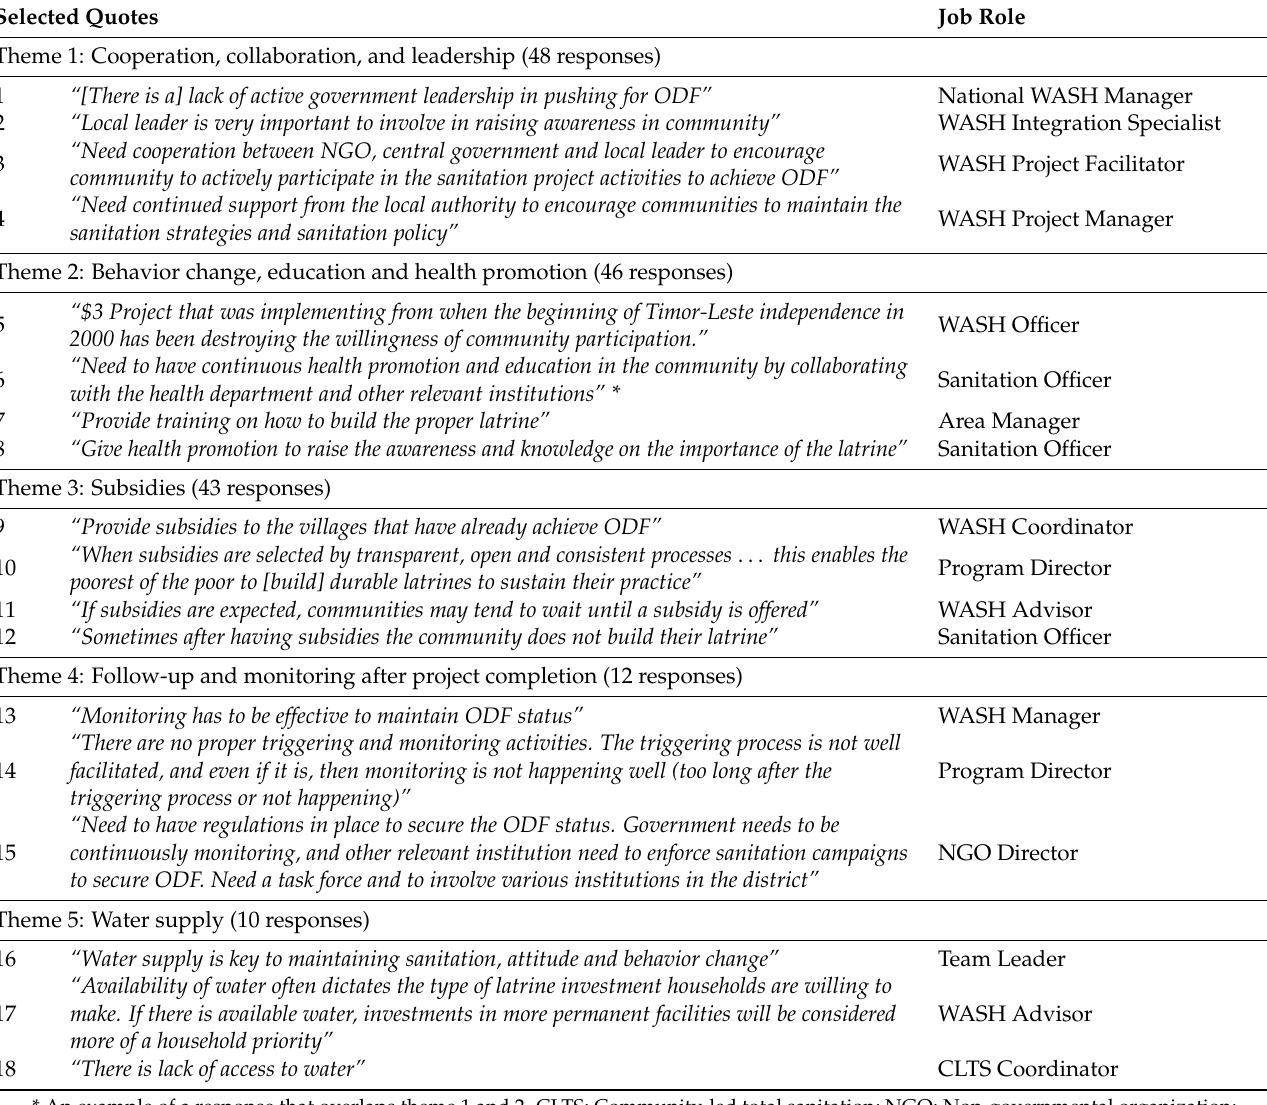
Table 4. Selected quotes from stakeholders relating to five main